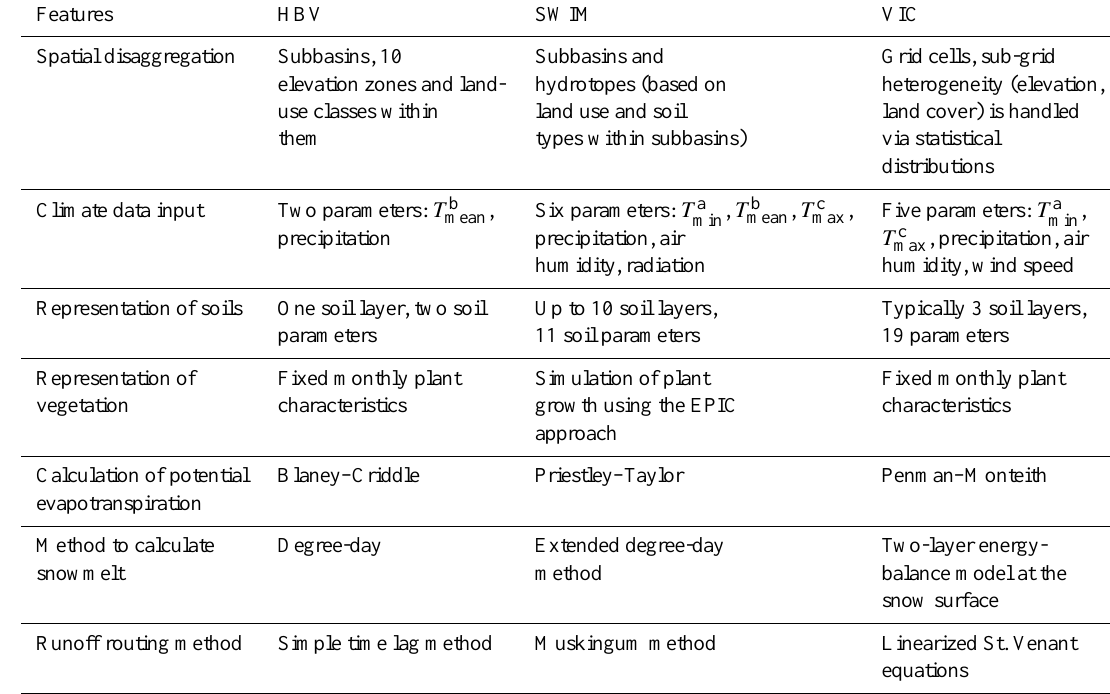
Table 2. Differences between spatial disaggregation, climate input and representation of main components in the three hydrological models used in the